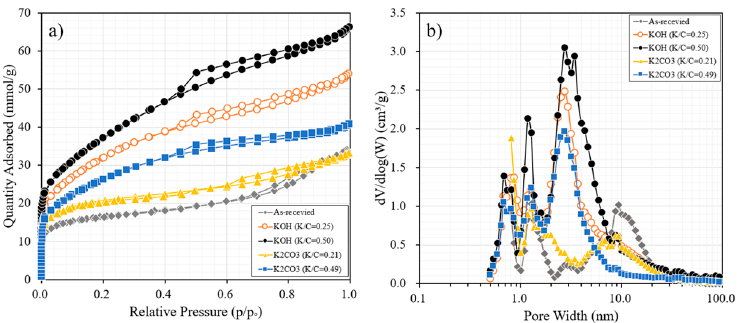
Figure 2. XRD patterns for KOH/K 2 CO 3 ‐ impregnated carbon precursors.